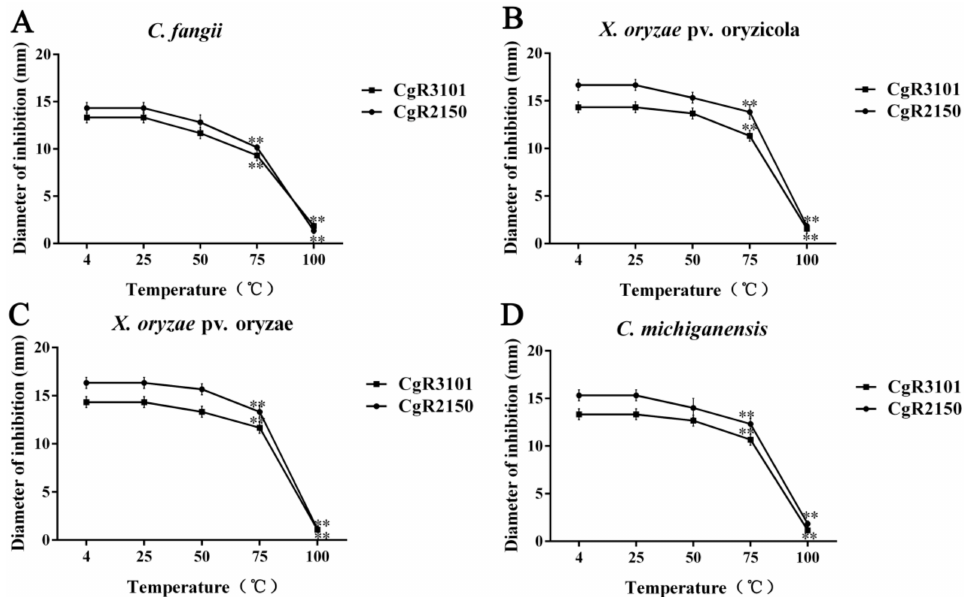
Figure 7. Thermal stability tests of CgR2150 and CgR3101. Antimicrobial peptides without tempera- ture treatment at 4 ◦ C were used as controls. ( A ) C. fangii , ( B ) X. oryzae pv. oryzicola, ( C ) X. oryzae pv. oryzae, and ( D ) C. michiganensis are the bacteriostatic diameter of the two peptides at different temperatures (25 ◦ C, 50 ◦ C, 75 ◦ C, and 100 ◦ C). The data are the mean values obtained after three independent experiments, and the vertical bars are the standard deviations (SD). Significance analysis was performed by t -test; ** p < 0.01.